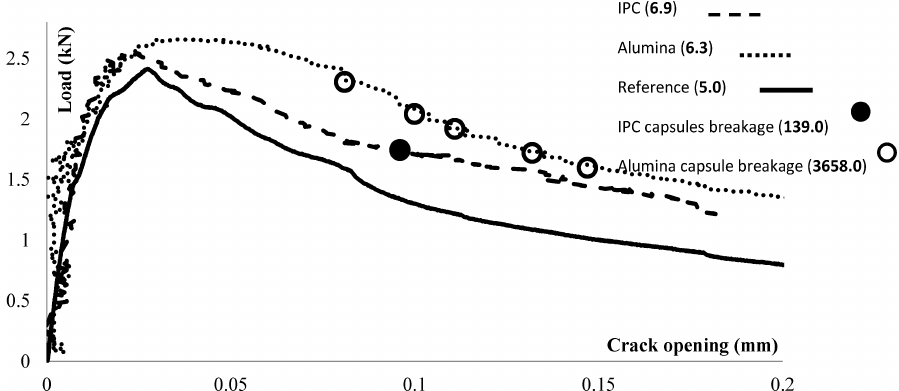
Figure 2. Reference beam and beams carrying ceramic (alumina) and cementitious (IPC) capsules loaded under three-point-bending.